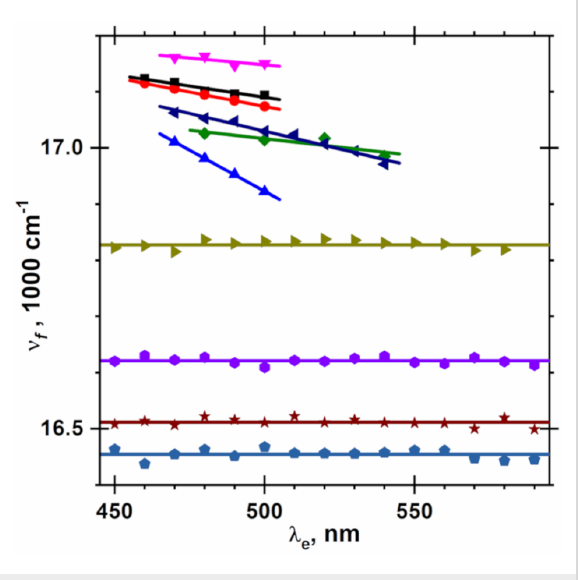
Figure 5: Dependence of the fluorescence maximum ( ν f ) of NR on the excitation wavelength ( λ e ) in rigid PMMA matrix (six data sets on the top) and in fluid solutions (four data sets on the bottom) at 25 °C. The details of the preparation of the submicron PMMA films are listed in Table 3. The straight lines for NR in the PMMA matrices and hori- zontal lines for NR fluid solutions at λ e = 500 nm are shown from top to bottom in the following series: PMMAH from CH 2 Cl 2 , PMMAL from CH 2 Cl 2 , CHCl 3 and (CH 2 Cl) 2 , PMMAH from CHCl 3 and (CH 2 Cl) 2 , ethyl acetate, CHCl 3 , CH 2 Cl 2 , and (CH 2 Cl) 2 , respectively.